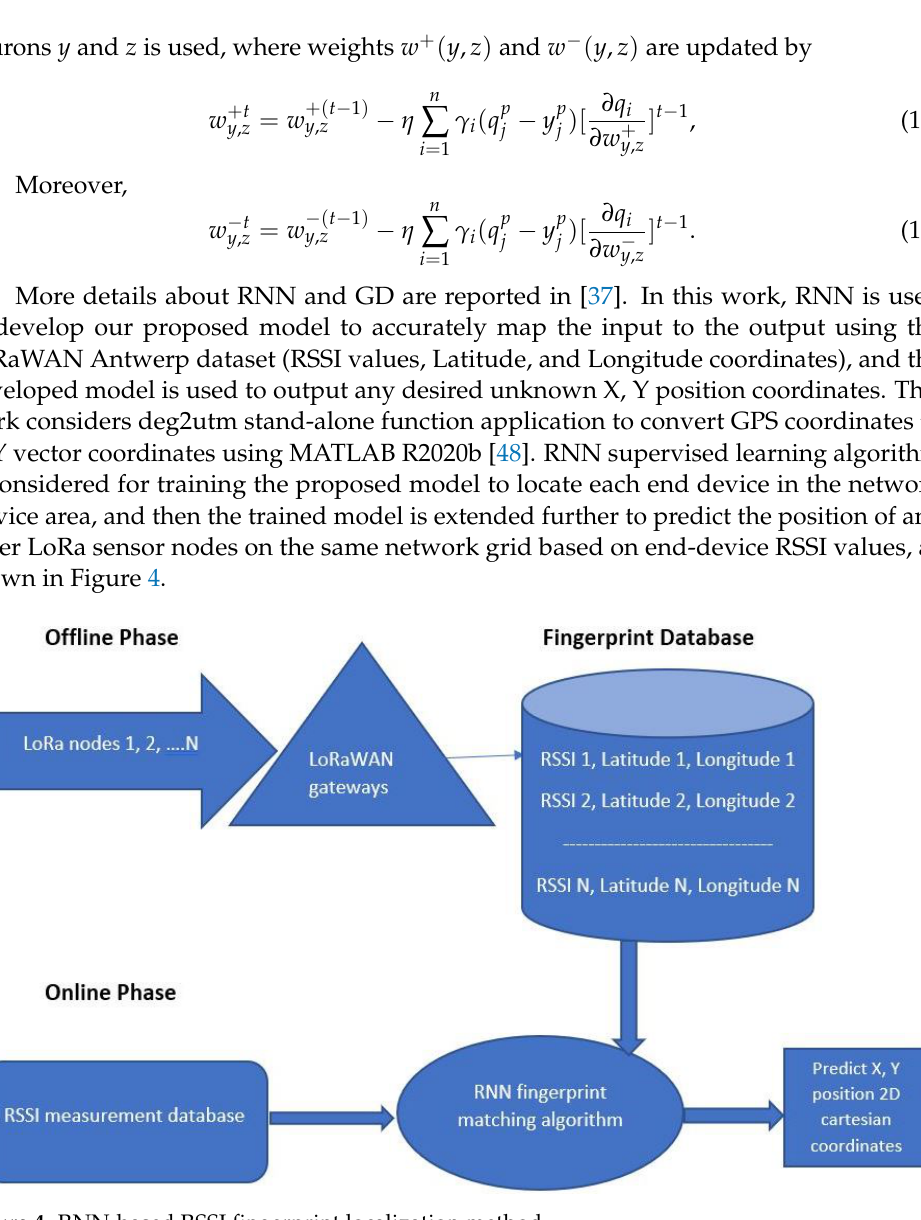
Figure 4. RNN-based RSSI fingerprint localization